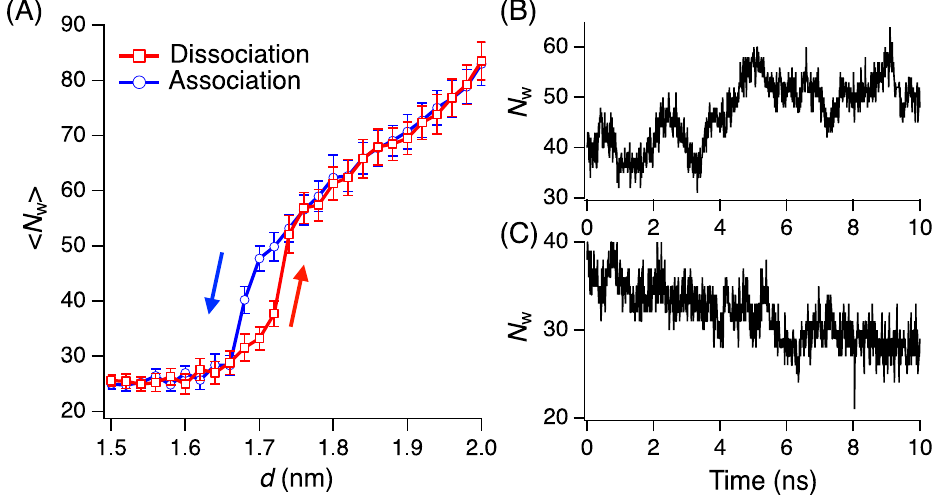
Figure 2. Number of water molecules N w between two proteins; ( A ) the average, < N w >, as a function of the intersolute distance d during the association (blue) and dissociation (red) processes, and the time evolution of N w at ( B ) d = 1.74 nm during the dissociation, and ( C ) d = 1.66 nm during the association.